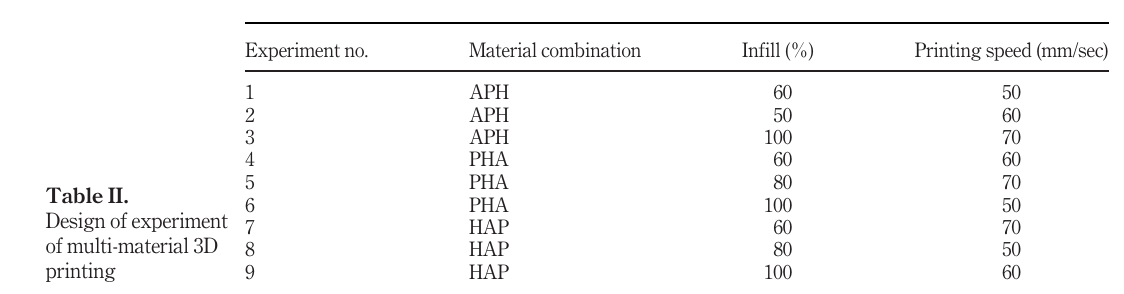
Figure 5. Photographic view of the experimental setup for extrusion of feedstock fi